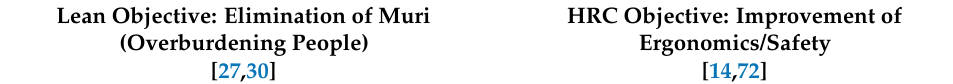
Table 1. Comparison of scope between lean’s goal for Muri elimination and HRC’s goal for improved